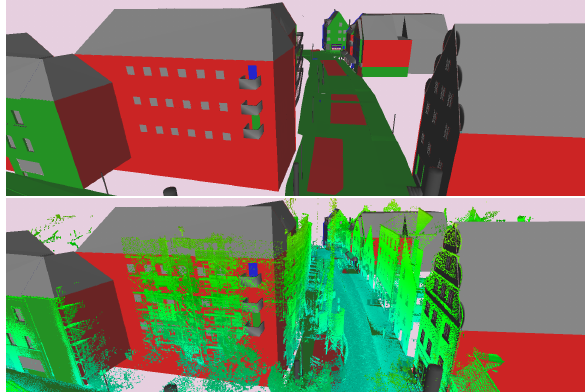
Figure 7. Colored building and street models for the inspection of the point distance distribution - green object surfaces indicate that the median is located within the tolerance range. Blue indicates a significant displacement towards the inner of the building and red indicates to the exterior.